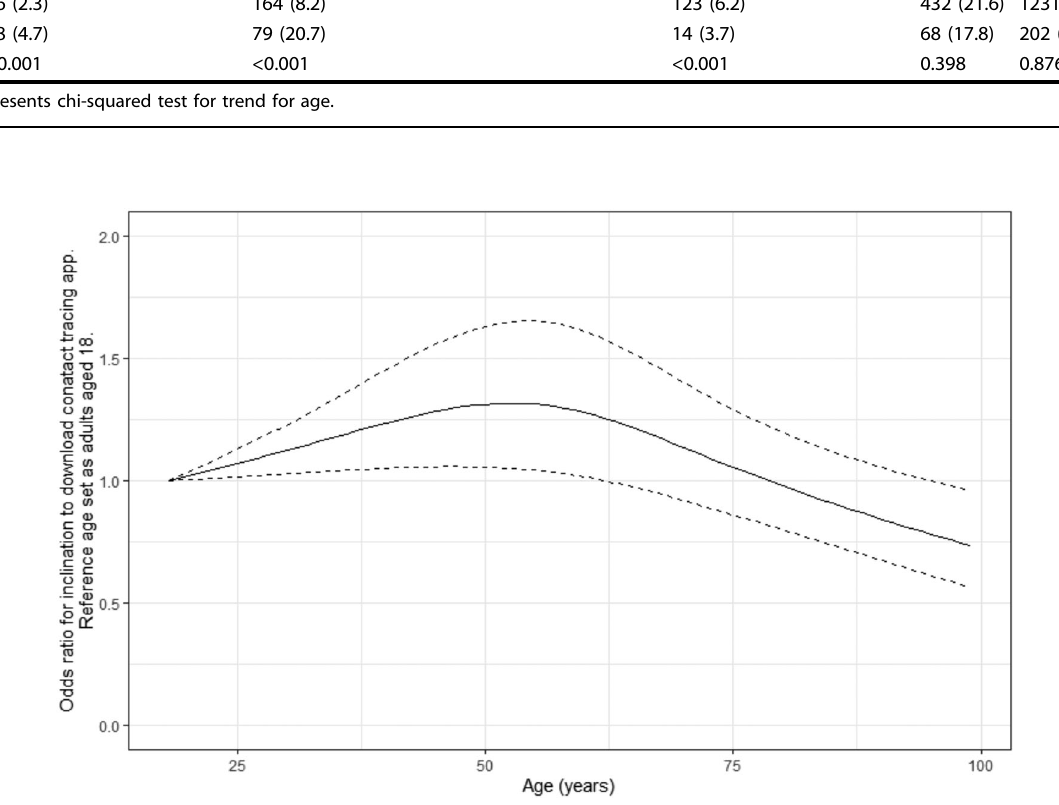
Fig. 1 Odds ratio for the effect of age on the inclination to download a contact-tracing app, using a univariate logistic regression model with a restricted cubic spline transformation applied to age. Model uses 3 knots applied at the 0.1, 0.5 and 0.9 quantiles of the age distribution 30 . Solid line represents odds ratios against a reference of age 18. Dotted lines represent 95% con fi dence intervals. Model formula on log odds scale: 0.904 + 9.76e − 03 * age − 8.392e − 06 * (age − 33.0) + 3 + 2.024e − 05 * (age − 57.0) + 3 − 1.185e − 05 * (age − 74.0) + 3 .